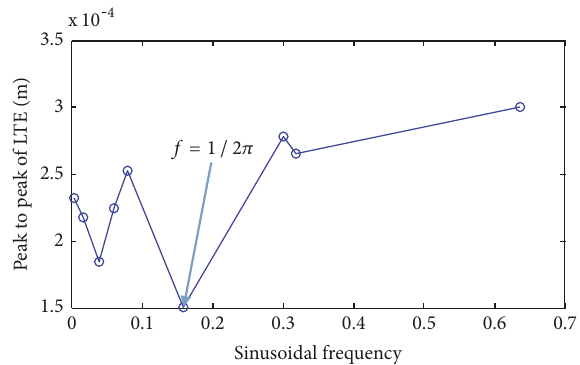
Figure 14: Peak-to-peak value of LTE under different frequencies of sine load